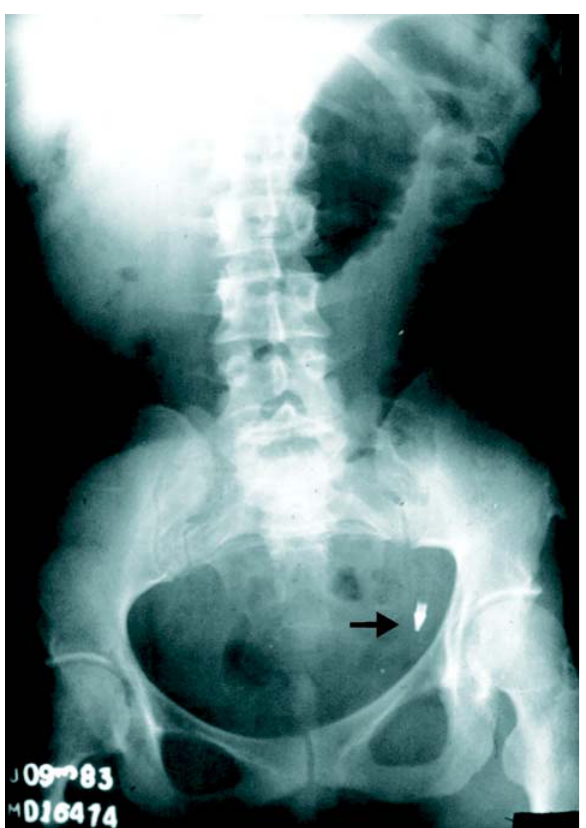
Figure 1 – Abdominal X-ray revealed a radiopaque foreign body (white arrow) in left inferior quadrant compatible with a pen tip.